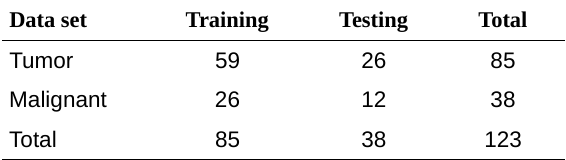
Table 3. Data set for SVM